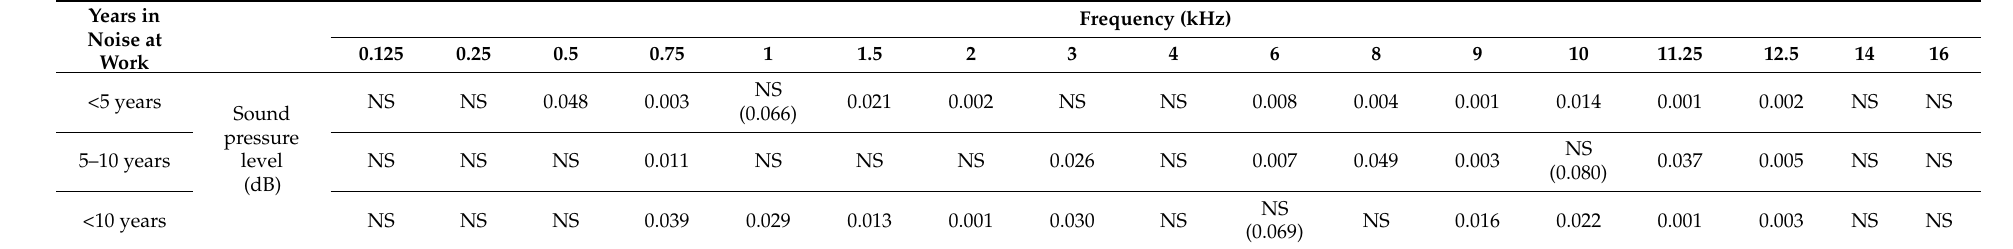
Table 4. Comparison of average hearing thresholds of respondents unexposed and exposed to noise, depending on the length of work-related exposure to noise (in terms of p -values). Years in Noise at